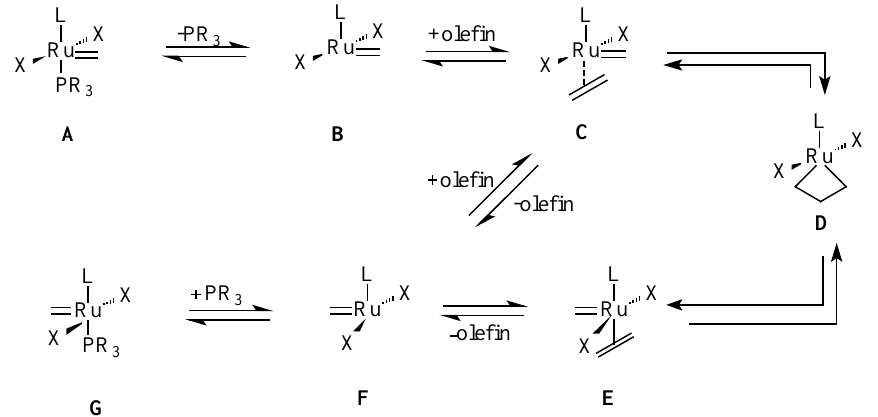
Scheme 3. Dissociative mechanism for Ru-catalysed olefin metathesis showing Ruthenium alkylidene ( A,G ); 14e intermediate ( B,F ); 16e species ( C,E ); ruthenacyclobutane ( D ).